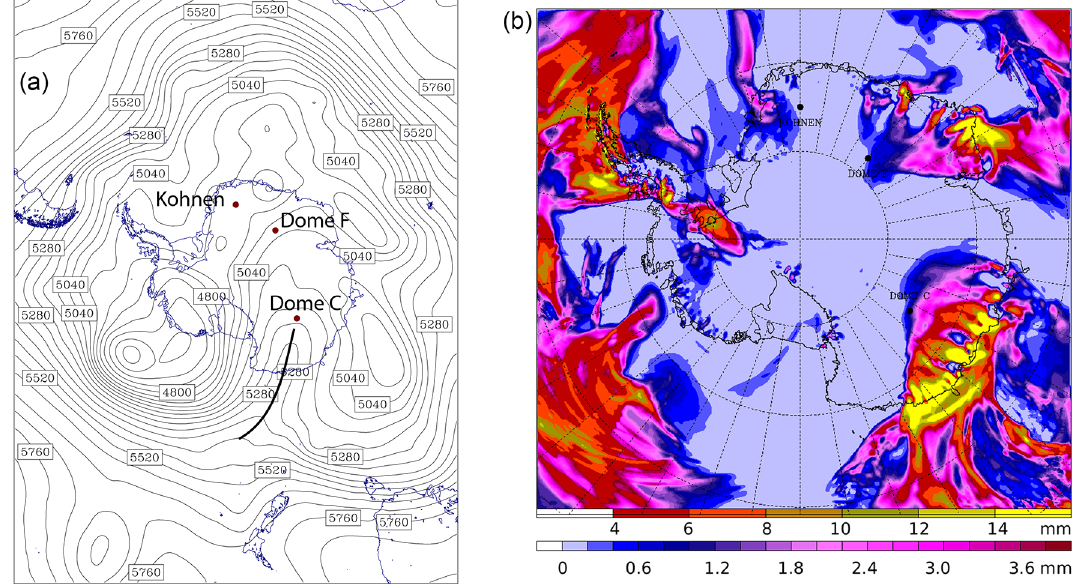
Figure 5. (a) 500hPa geopotential height from AMPS archive data (Domain 1) 13 September 2009 00:00GMT. The axis of the upper-level ridge mentioned in the text is marked by a bold black line. (b) 24h precipitation from AMPS 13 September 2009 00:00 to